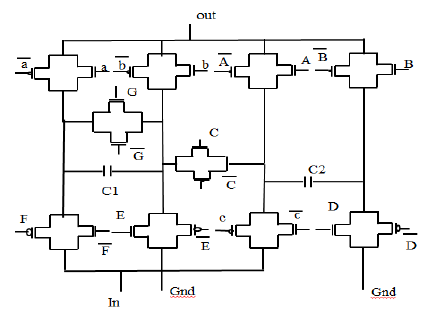
Figure 8. Circuit diagram of transmission gate-based switch capacitor converter using FINFET